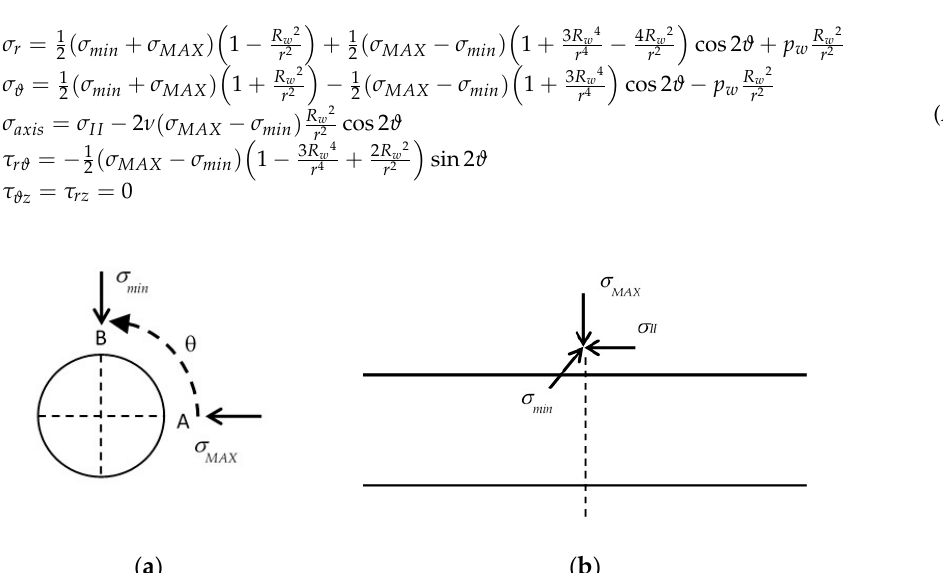
Figure A5. In situ stresses considered in the Kirsch Equations.